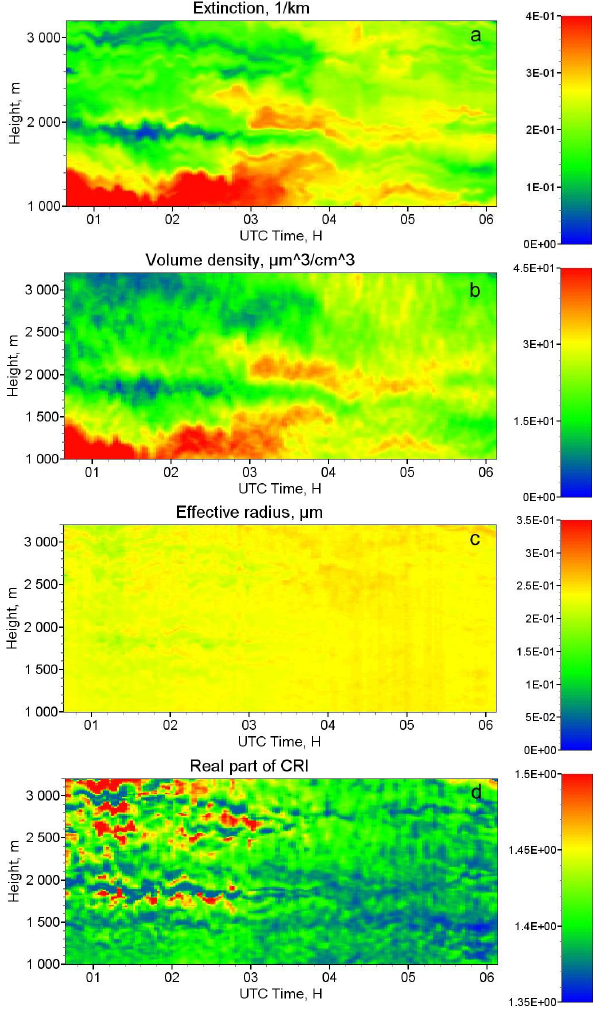
Fig. 5. Spatio-temporal distribution of (a) particle extinction at 355nm calculated from the nitrogen Raman signal together with (b) particle volume, (c) effective radius and (d) the real part of the complex refractive index on 21 July 2011.